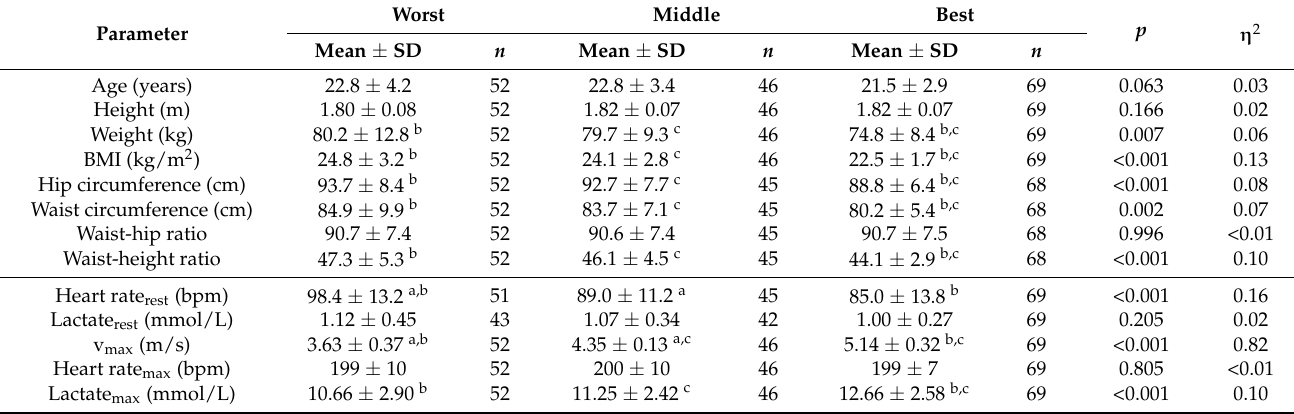
Table 2. Men’s characteristics, divided by performance groups.